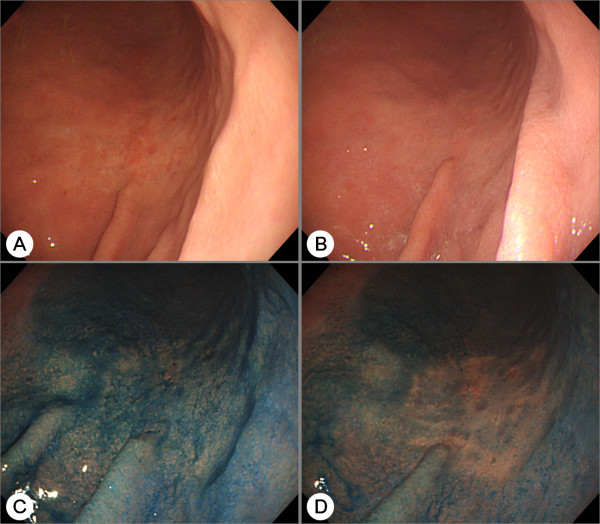
Chromoendoscopy of an undifferentiated adenocarcinoma. (A) A flat discolored lesion with an unclear border at the lower body of the stomach is shown. (B) Endoscopic view after acetic acid was sprinkled. (C) Endoscopic view after indigo carmine was additionally sprinkled. (D) Endoscopic view after the lesion was washed with clean water. After chromoendoscopy with indigo carmine dye added to acetic acid, the lesion's border was still indistinct and the image was mottled. The lesion was resected by laparoscopic gastrectomy and was shown to be an undifferentiated adenocarcinoma.